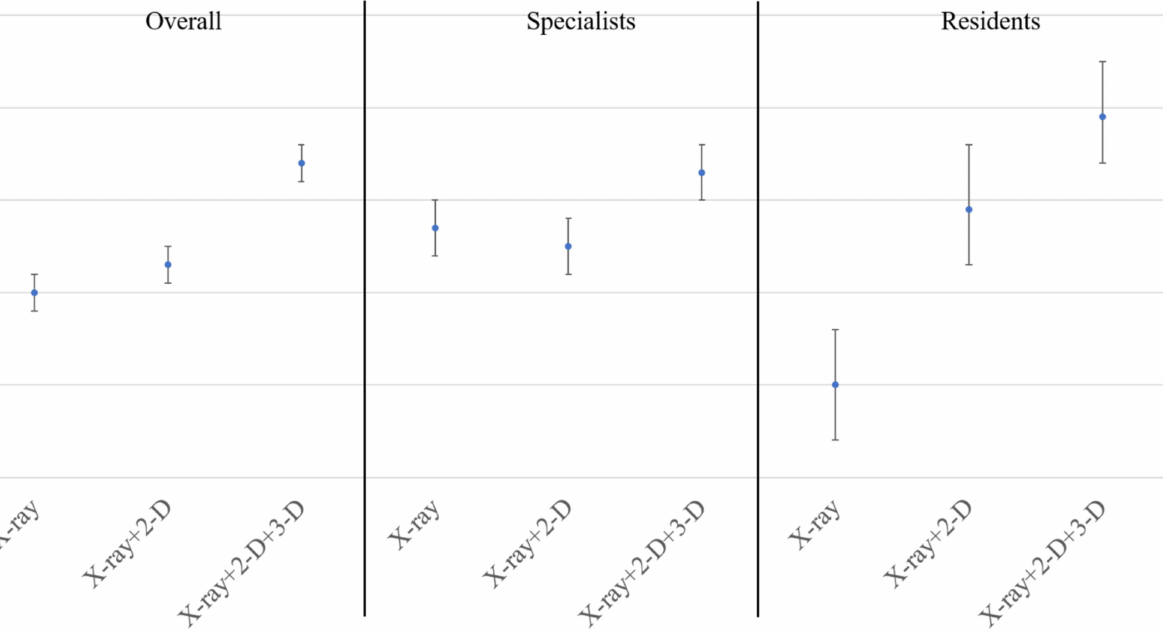
Figure 2. Interrater reliability of the AO/OTA classification. Blue dots indicate the calculated Fleiss kappa coefficient. Error bars indicate the 95% confidence interval. 2-D, two-dimensional computed tomography. 3-D, three-dimensional computed